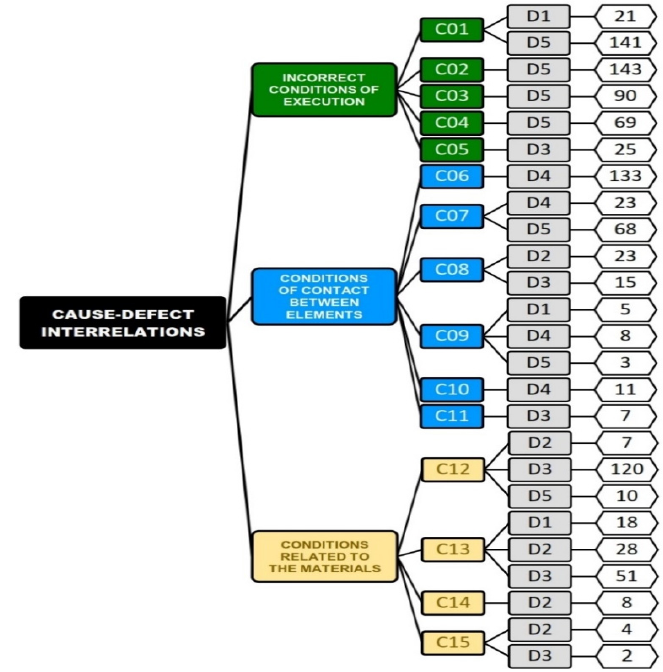
Figure 9. Descending tree chart of interrelations between types of causes and types of defects.